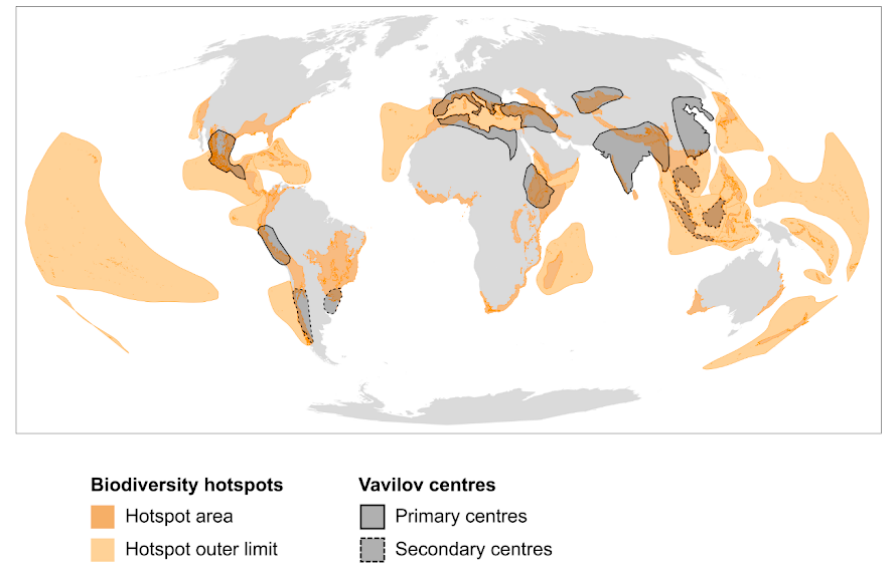
Figure 1. Global distribution of biodiversity hotspots and Vavilov centres. Biodiversity hotspots were first defined by Myers in 1988 [21], and now comprise 35 regions of high species richness, endemism and threat, as last updated in 2011 by Mittermeier and colleagues [18]. Islands constituting biodiversity hotspots are highlighted by outer hotspot limits. Vavilov first defined centres of origin of cultivated species and wild relatives in 1924; he provided an update in 1935, comprising eight primary and three secondary centres [27].